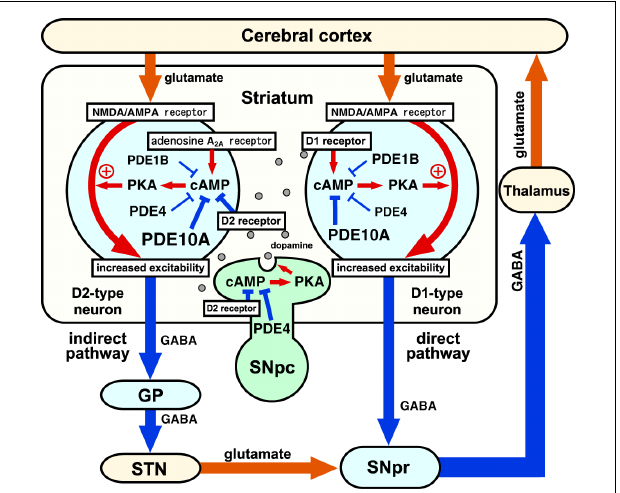
FIGURE 3 | Roles of phosphodiesterases (PDEs) in the control of basal ganglia–thalamocortical circuitry. Output neurons in the striatum are medium spiny neurons (MSNs), which consist of striatonigral/direct pathway and striatopallidal/indirect pathway neurons. Direct pathway neurons are GABAergic, and inhibit tonically active neurons in globus pallidus interna (GPi)/substantia nigra pars reticulata (SNpr). Indirect pathway neurons are also GABAergic, and activate neurons in GPi/SNpr via inhibition of globus pallidus externa (GPe) GABAergic neurons and activation of subthalamic nucleus (STN) glutamatergic neurons. Direct and indirect pathway neurons induce opposing effects on the output neurons in GPi/SNpr, resulting in dis-inhibition and pro-inhibition of output, respectively, to motor areas of the thalamus and cortex.The inhibition of PDEs increases cAMP/PKA signaling in both direct and indirect pathway neurons. PDE inhibitors that predominantly act in direct pathway neurons work like dopamine D 1 receptor agonists and activate motor function, whereas PDE inhibitors that predominantly act in indirect pathway neurons work like dopamine D 2 receptor antagonists and inhibit motor function. SNpc, substantia nigra pars compacta. Reproduced with permission from reference Nishi and Snyder